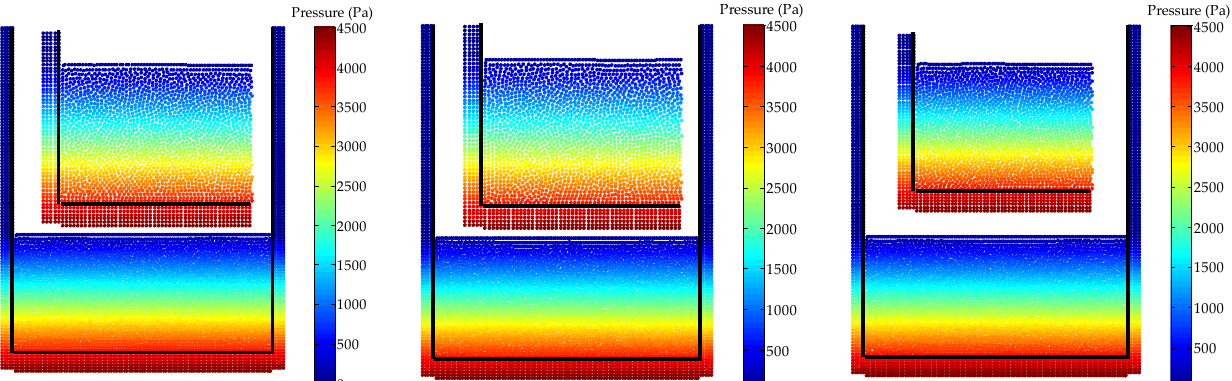
Figure 2. Pressure field and particle distribution at 15.0 s: ( a ) SPH results with Chen’s boundary method; ( b ) SPH results with Shao ’s boundary method ; ( c ). SPH results with the new boundary method.